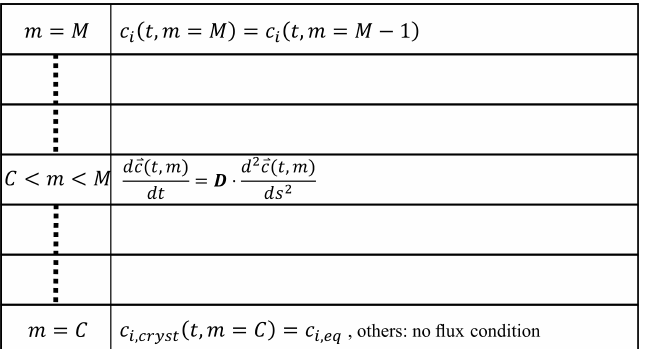
Figure 2. The numerical model: At m = C concentrations of crystallizing component are set to equilibrium conditions. No flux condition prevails for non-crystallizing components. At m = M , no flux condition for all components applies. The cells in between are modeled by Equation